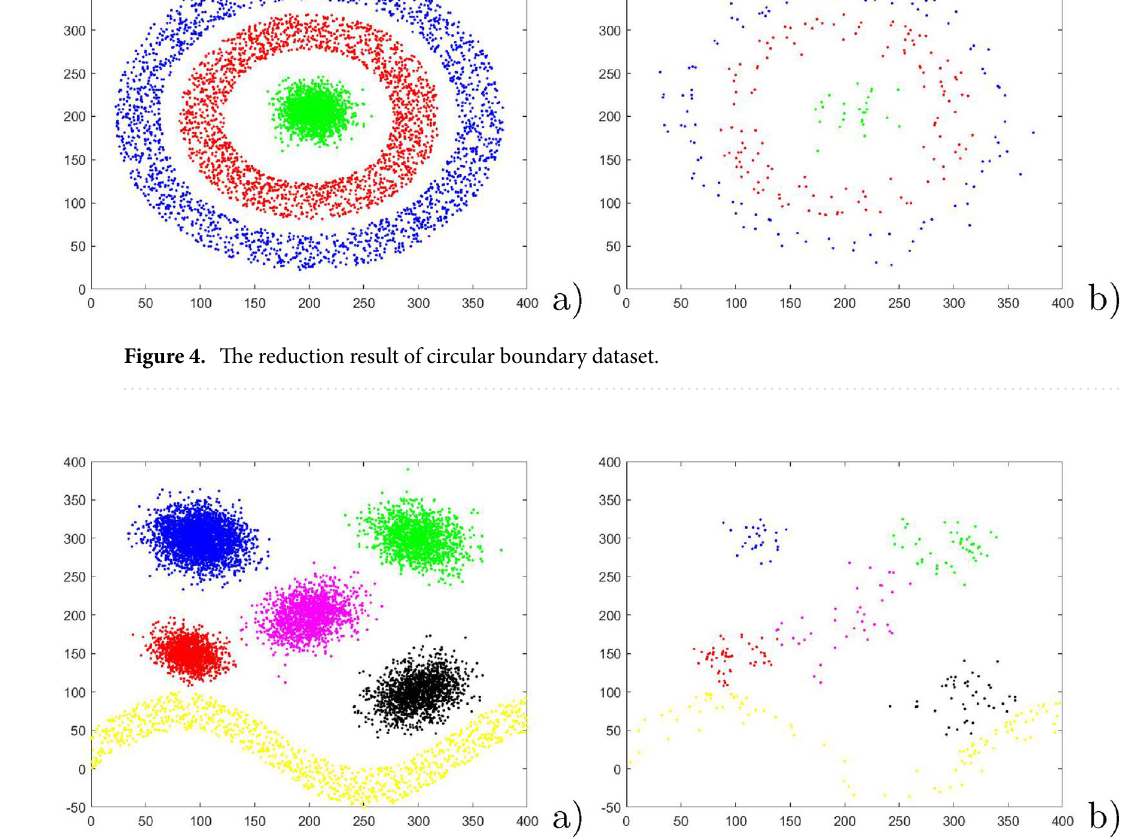
Figure 5. The reduction result of dataset with gaussian and sinusoidal